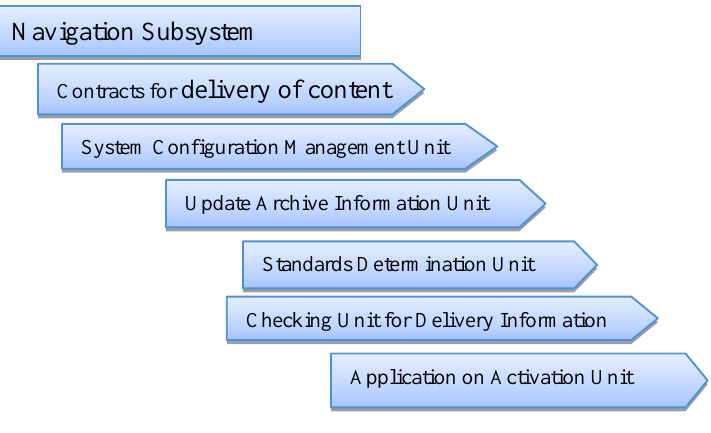
Figure 4: Components of the navigation